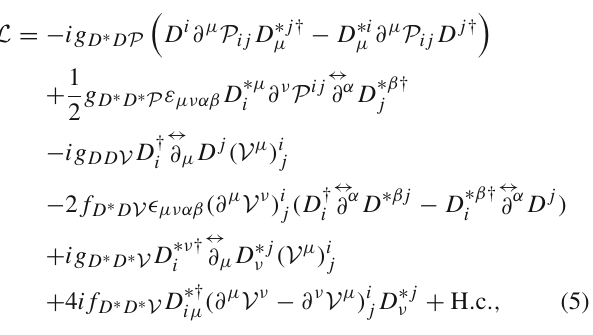
Fig. 1 Diagrams contributing to X ( 3872 ) → J /ψρ . The charge con- jugate diagrams are not shown but included in the calculations